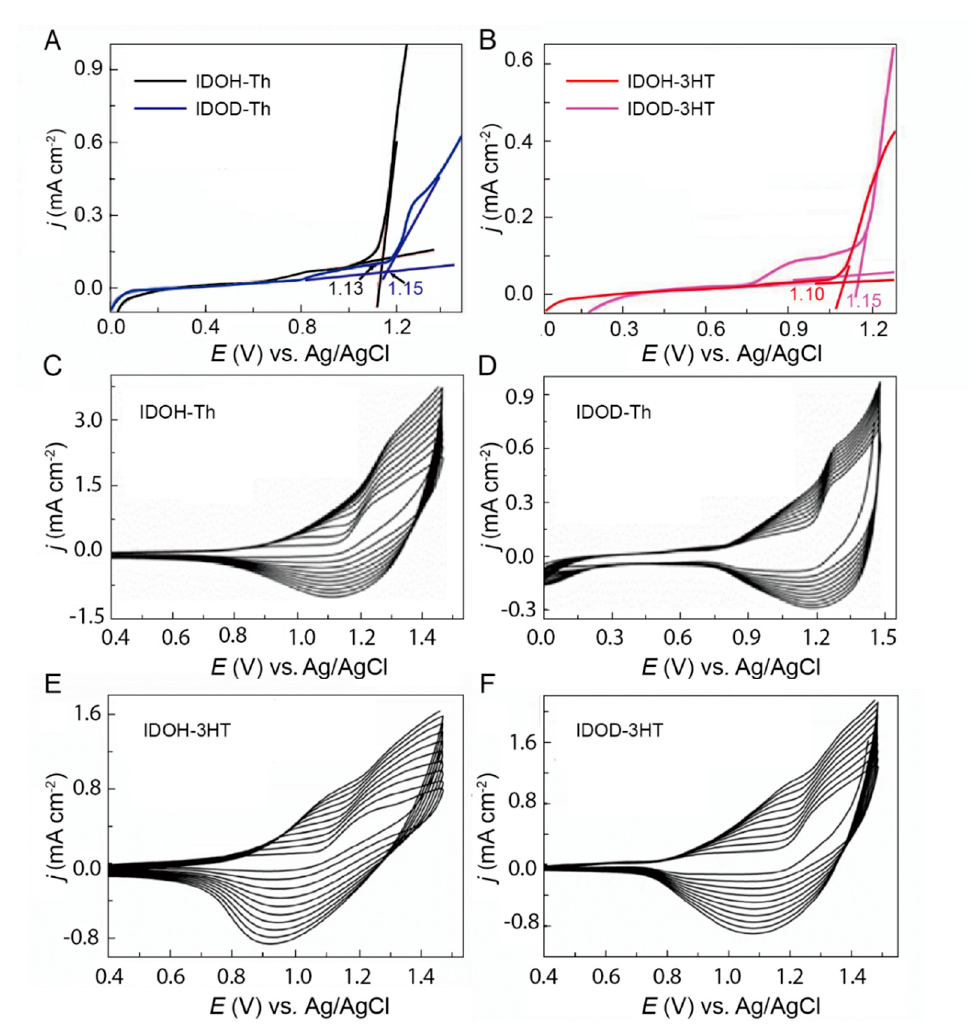
Figure 2. Anodic oxidation curves of 0.01 mol L − 1 ( A ) IDOH–Th, IDOD–Th, and ( B )